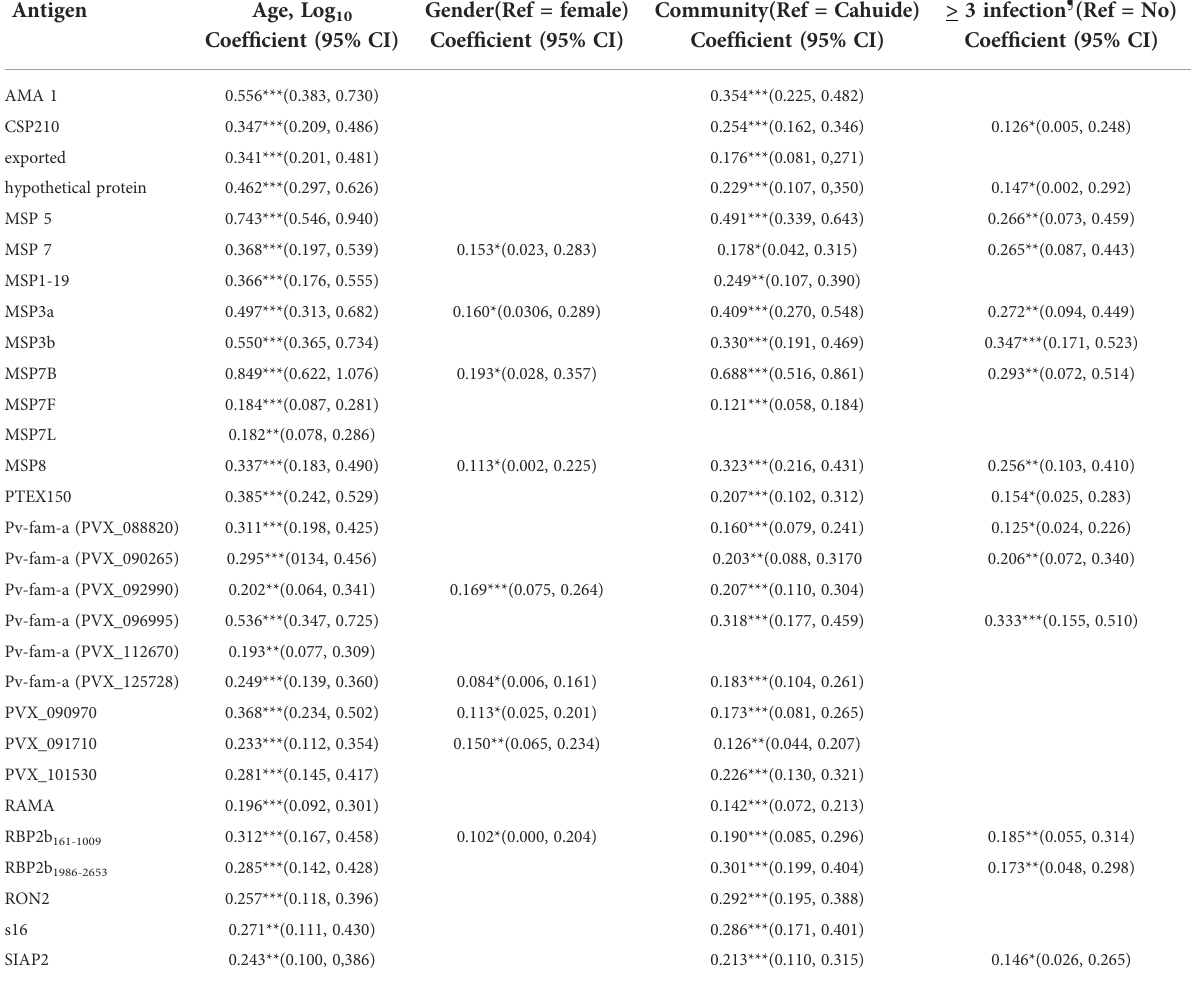
TABLE 2 Multivariable linear regression model of the effect of epidemiological factors on IgG3 antibody level in the Peruvian cohort.